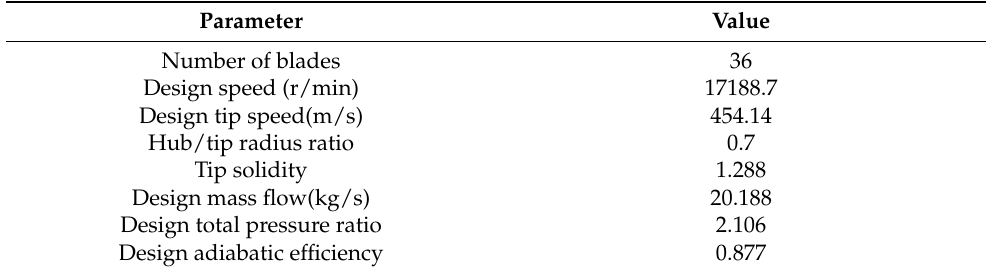
Table 1. The basic parameters of rotor 37.